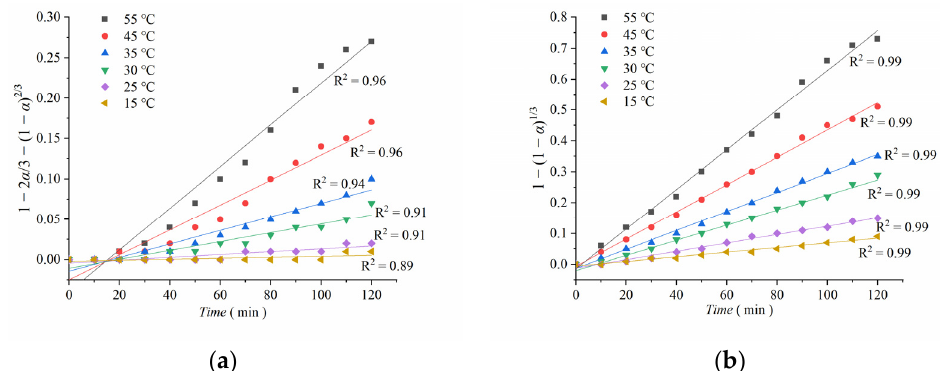
Figure 3. The fit of the diffusion rate expression versus time for ( a ) diffusion inside the solid and ( b ) chemical reaction.